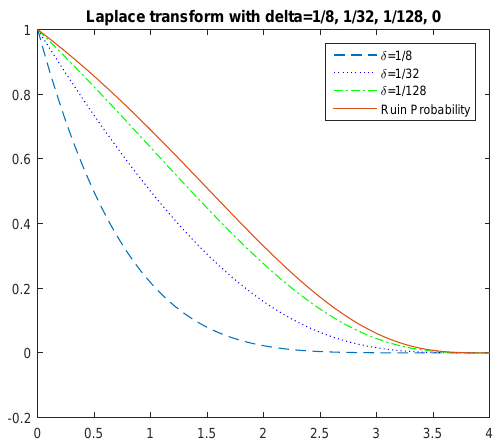
Figure 5. Laplace transform of the time of ruin for exponential mean one gains when δ = 1